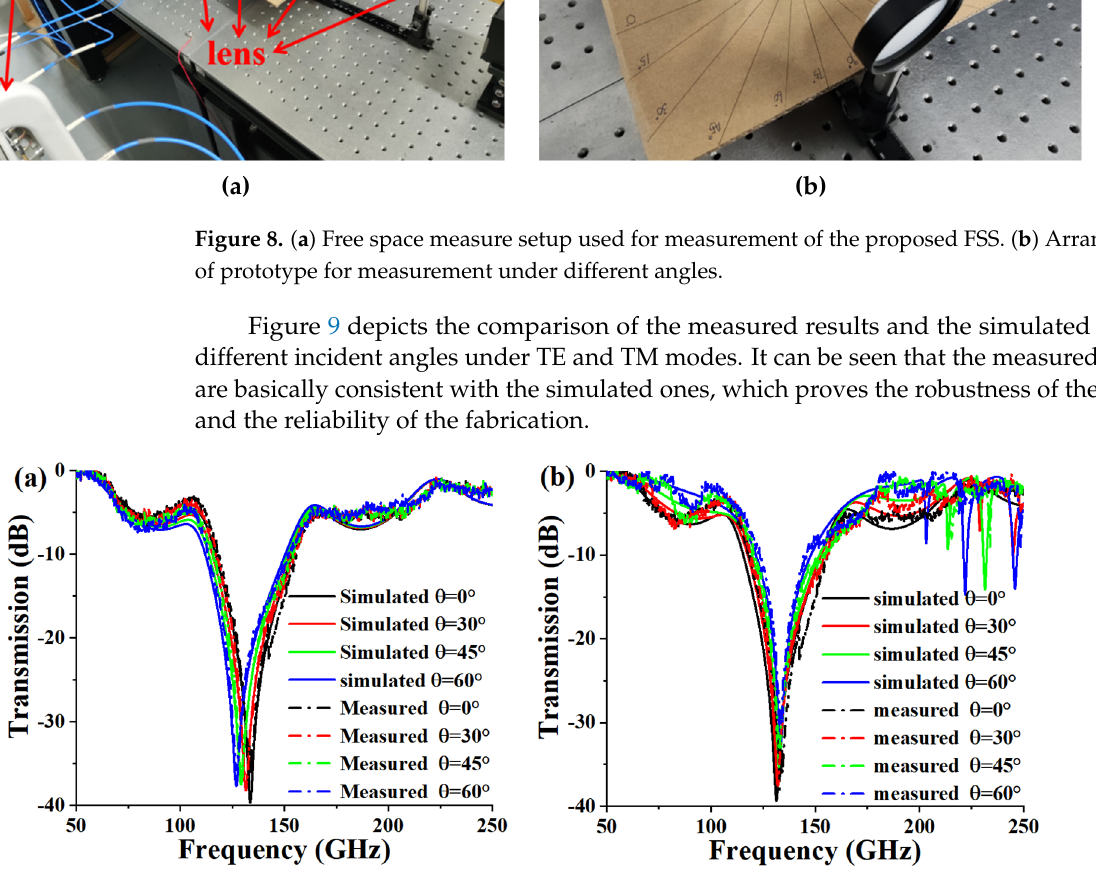
Figure 8. ( a ) Free space measure setup used for measurement of the proposed FSS. ( b ) Arrangement of prototype for measurement under different angles.